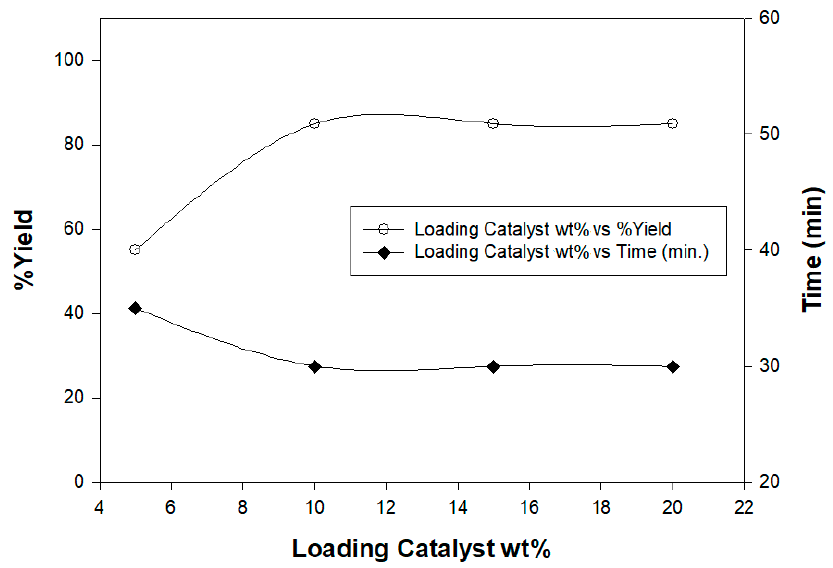
Table 1. Recyclability of the chitosan graft copolymer as basic catalyst.